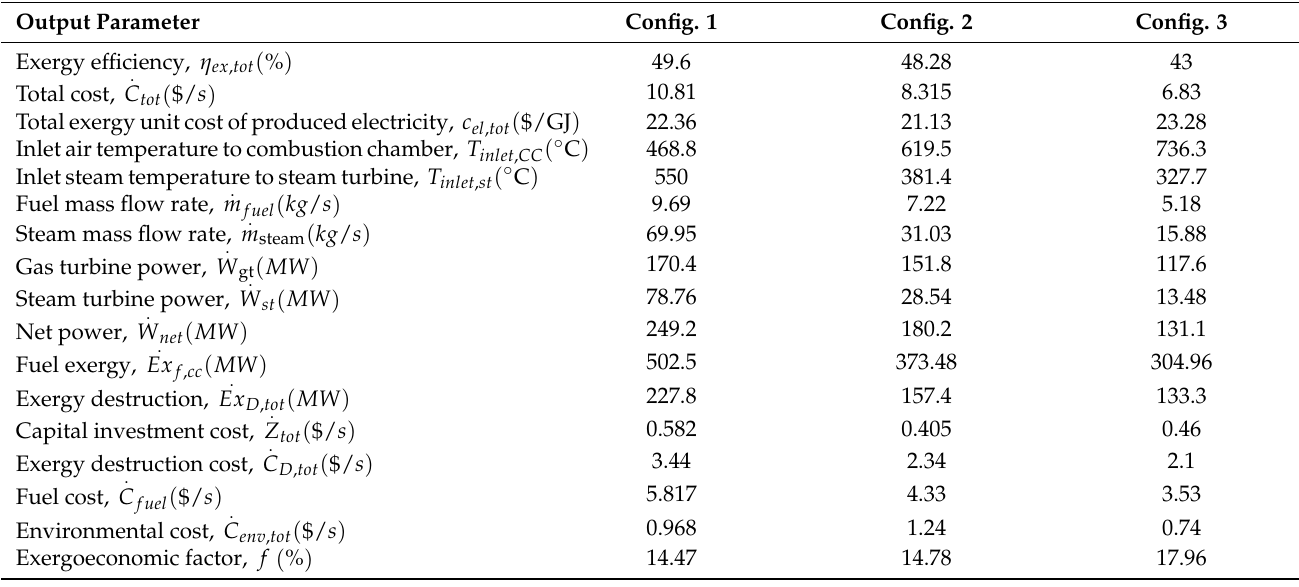
Table 17. The values of the output parameters and objective functions corresponding to the optimal